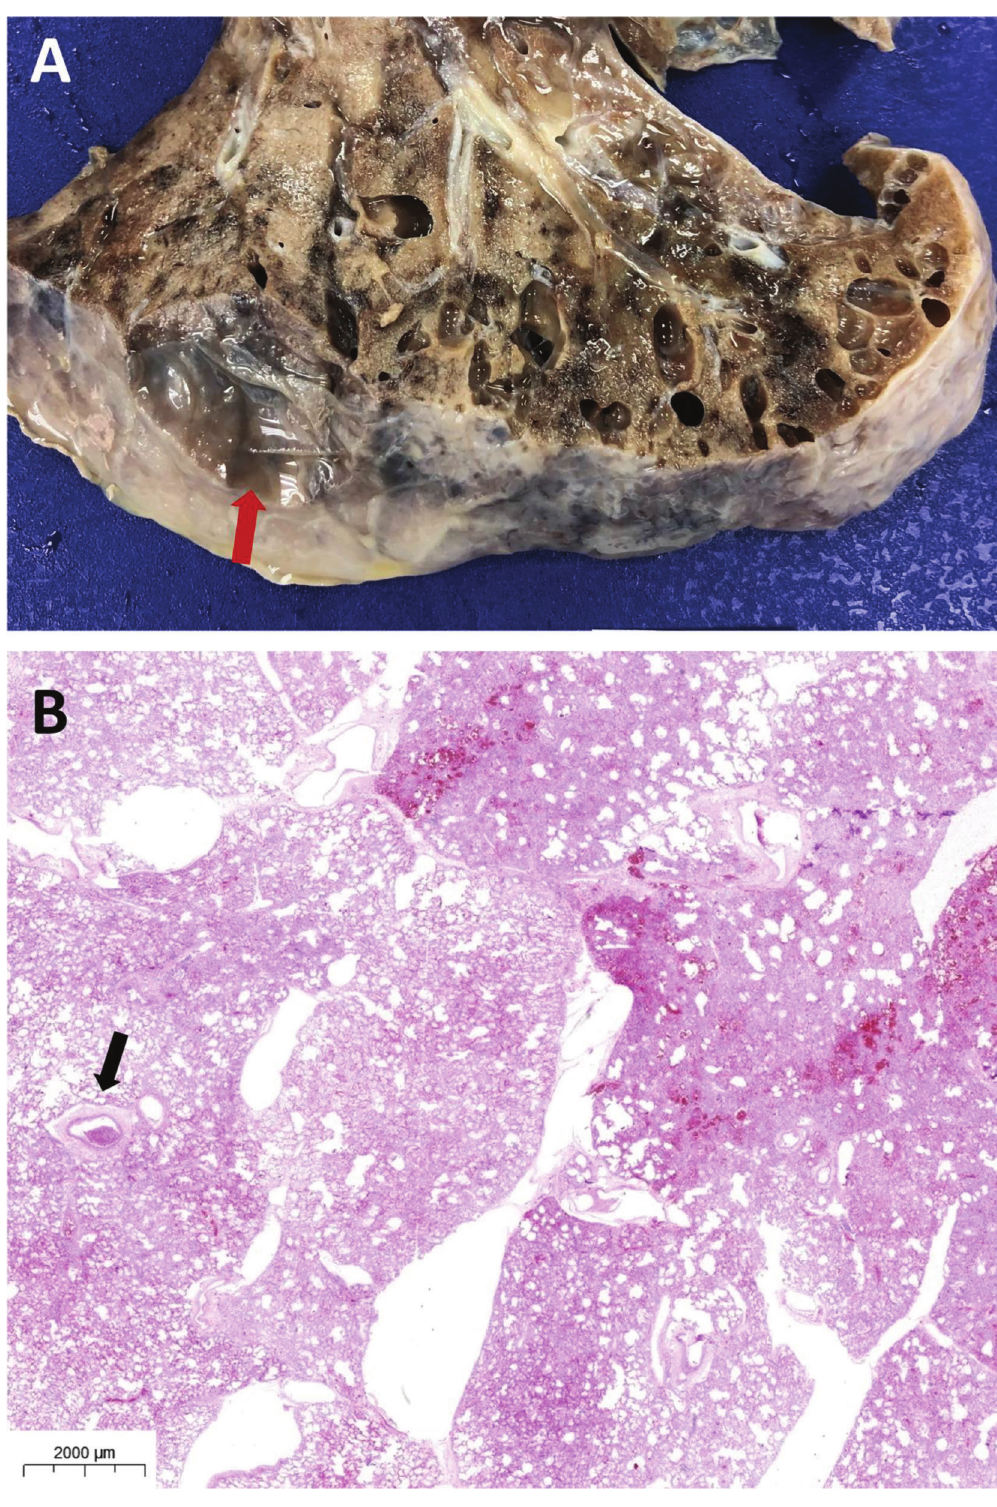
Figure 6 - Female, 17 years old, 20 days of hospitalization, 16 days of mechanical ventilation. Bilateral pneumothorax and subcutaneous emphysema in the chest and face reported 9 days before death. A : Multiple areas of pulmonary interstitial emphysema secondary to barotrauma. Note a ruptured subpleural bubble (arrow). B : Pulmonary interstitial emphysema; air dissects along connective tissue sheaths of the bronchovascular bundles and interlobular septa. Arrow: arteriolar thrombus.